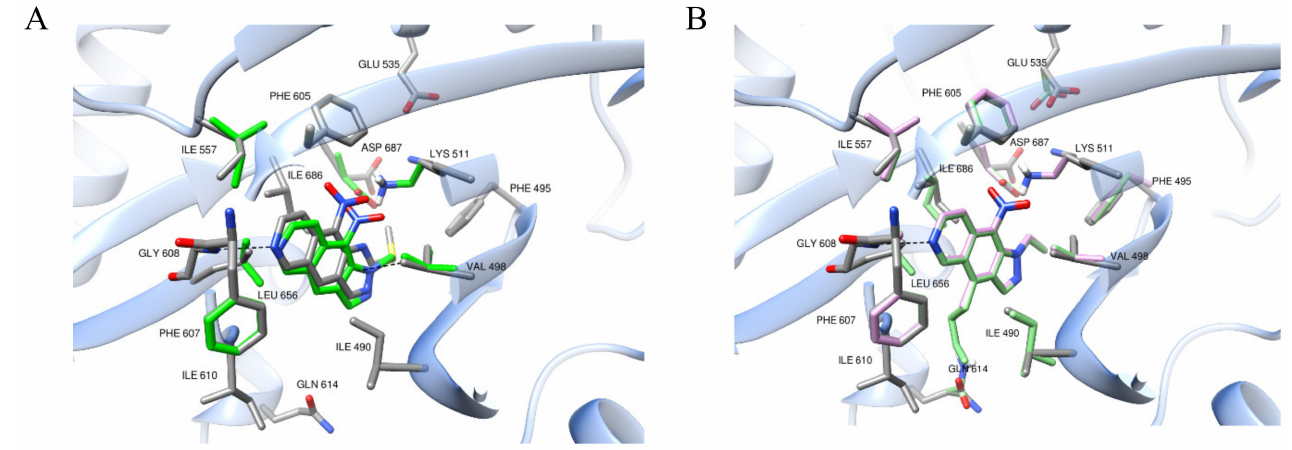
Figure 2. Plausible binding mode of 1c , 3a and 3e within Haspin ATP-binding site. ( A ) Superimpo- sition of II (grey color) and 1c (green color). ( B ) Superimposition of 3a (purple color) and 3e (light green) color. The images were produced using UCSF Chimera